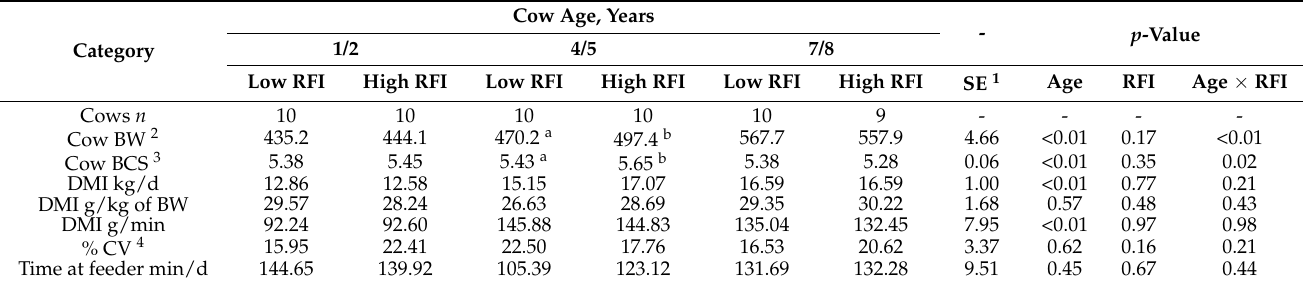
Table 2. The influence of heifer post-weaning RFI on subsequent beef cow performance and dry matter intake behavior of 3 age classes of non-lactating, pregnant beef cows (Study 1).